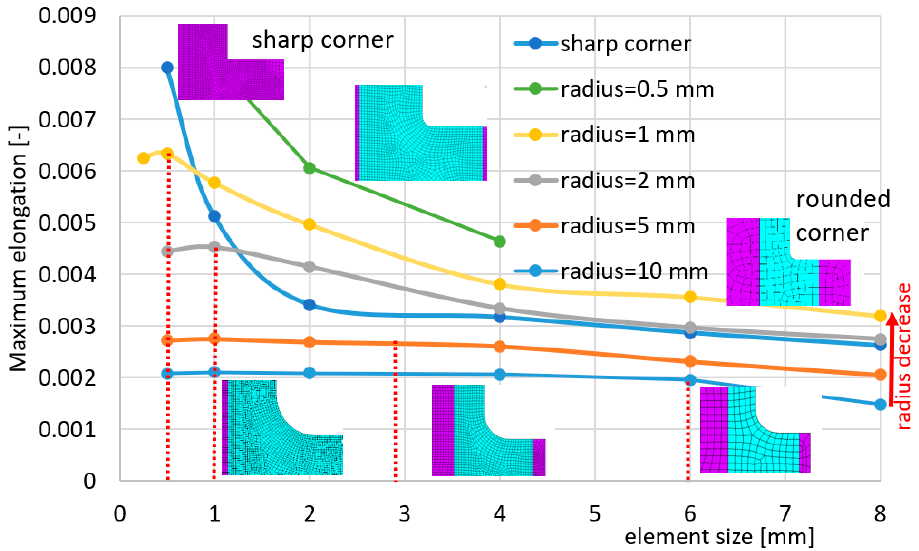
Figure 3. E ff ect of rounding radius and FE mesh size on the maximum plastic elongations. Figure 3. Effect of rounding radius and FE mesh size on the maximum plastic